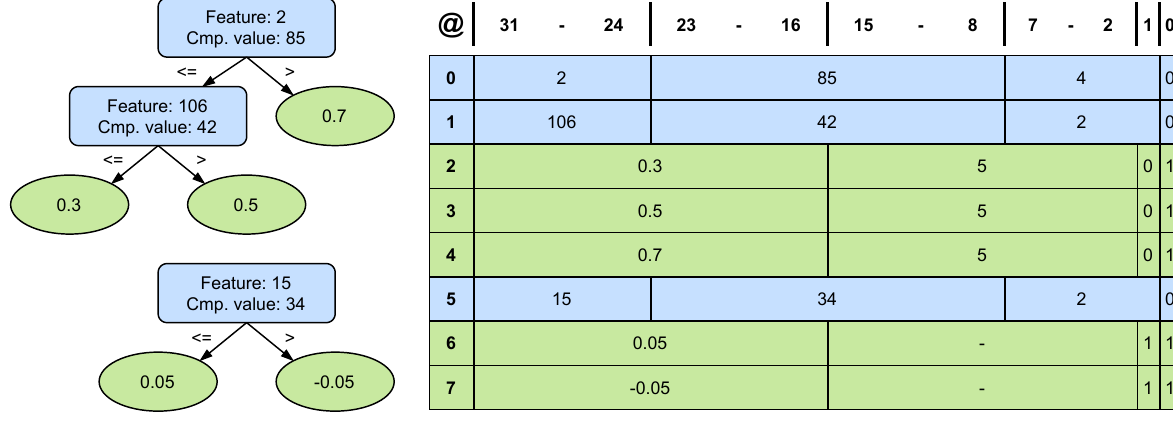
Figure 4. Trees representation